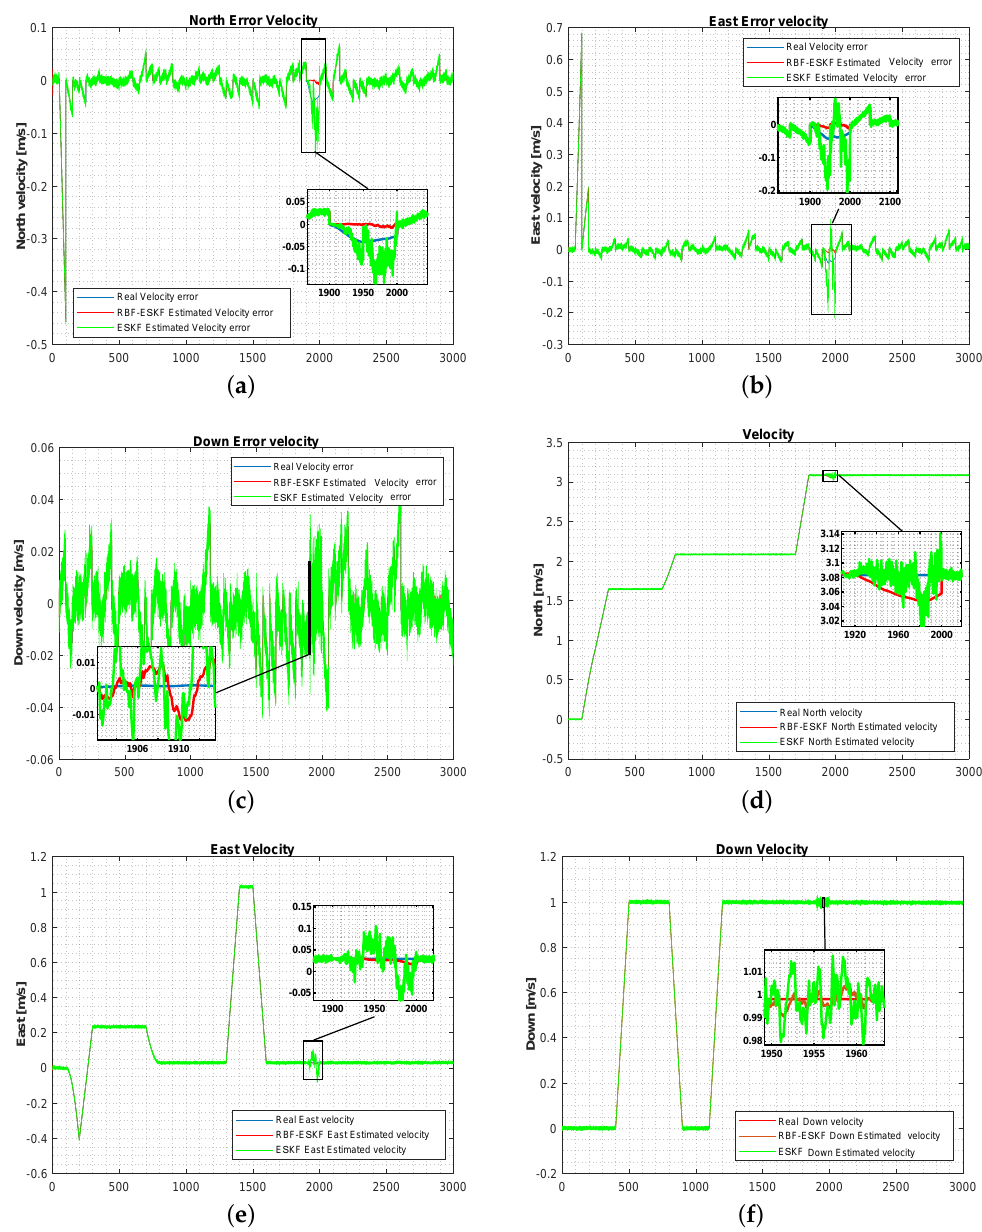
Figure 7. Simulation results of ESKF and RBF-ESKF for time 0–3000 s (x-axis) in case 3. As the error increases, nonlinearity in the error also increases. ( a – c ) The velocity error for the north, east, and downward directions increase significantly with DVL loss. The proposed velocity error estimate of the algorithm is similar to real error. ( d – f ) RBF-ESKF has a smoother response and faster convergence of the full state velocity